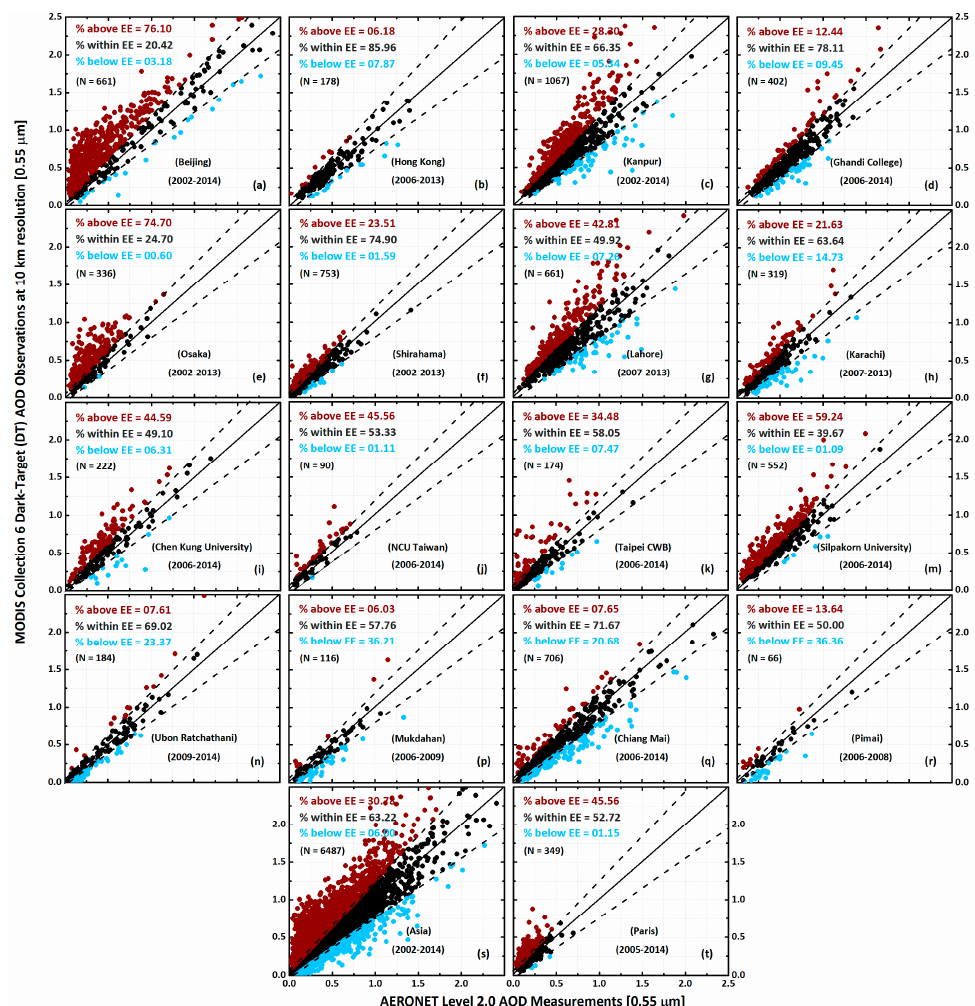
Figure 2. Validation of MYD04_10K AOD observations against AERONET measurements over ( a ) Beijing; ( b ) Hong Kong; ( c , d ) India; ( e , f ) Japan; ( g , h ) Pakistan; ( i – k ) Taiwan; ( m – r ) Thailand; ( s ) combined a to r sites; and ( t ) Paris. The dashed lines = EE lines and black solid line = 1:1 line. Retrievals are selected using a sampling window of 3 × 3 pixels (average of 900 km 2 spatial region for the MYD04_10K AOD at 3 km) centered on the AERONET site.